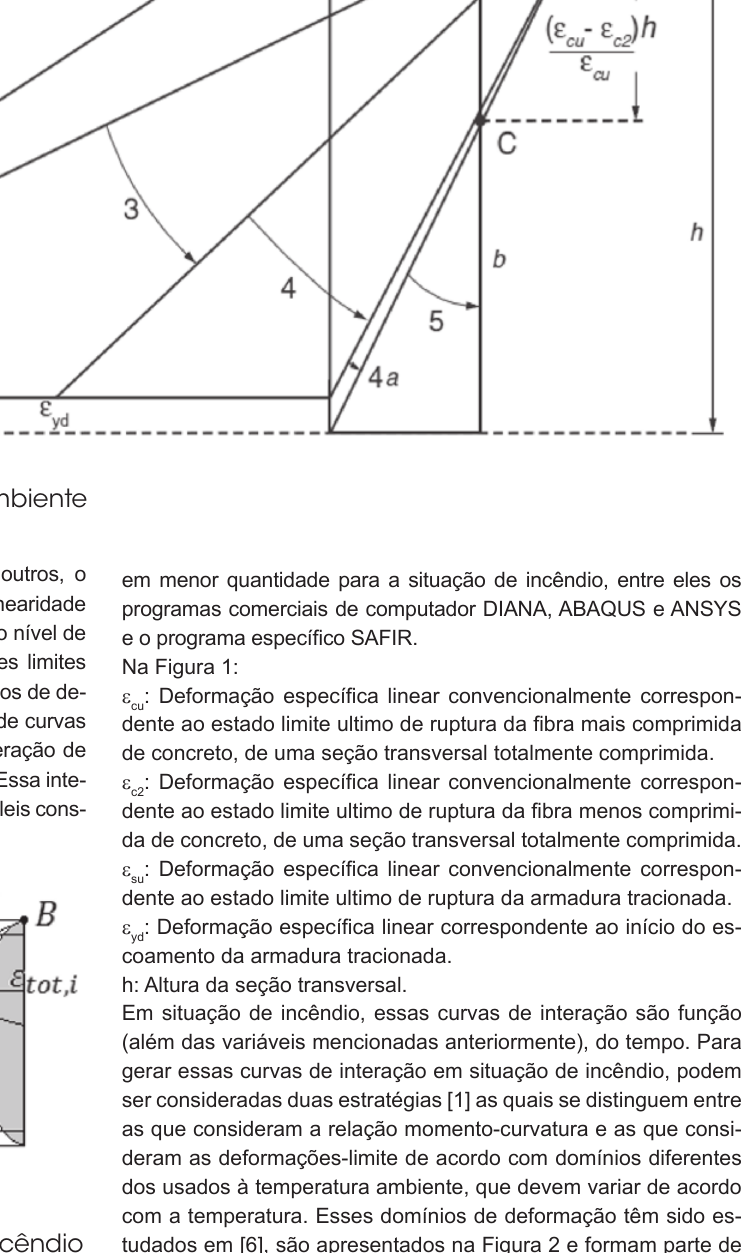
Domínios de deformação em situação de